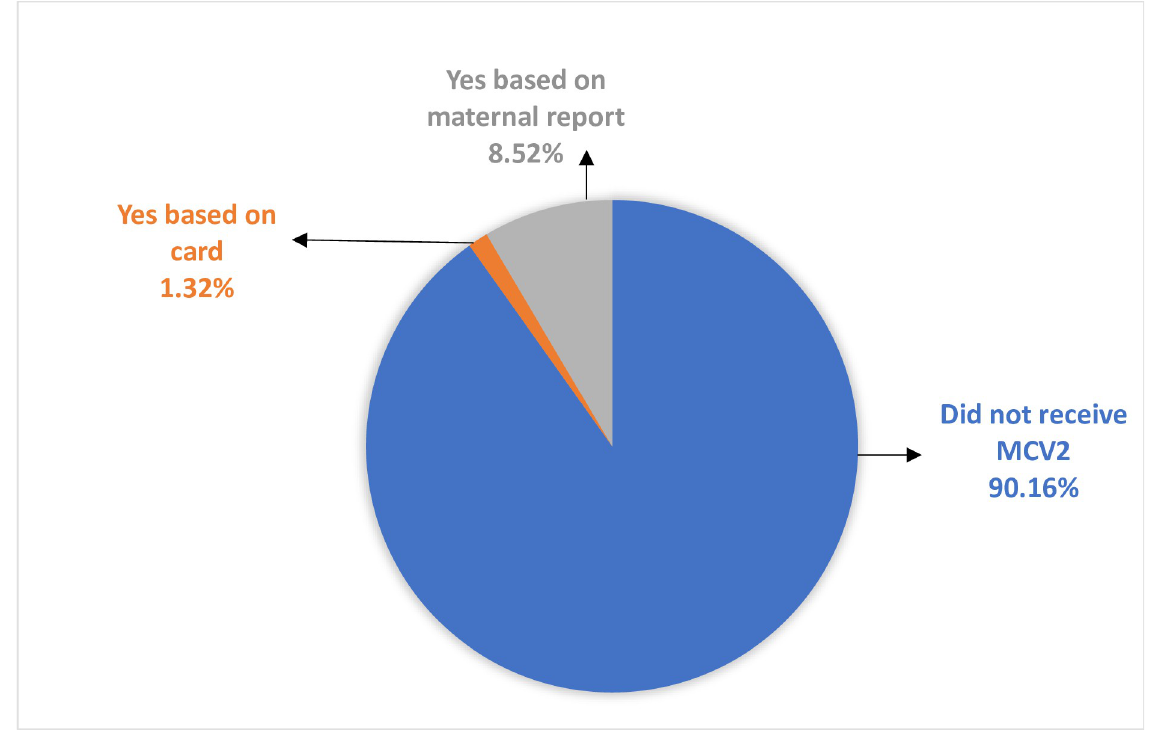
Fig 1. Proportion of the uptake of measles-containing second dose vaccine among children aged 24 to 35 months in Ethiopia.